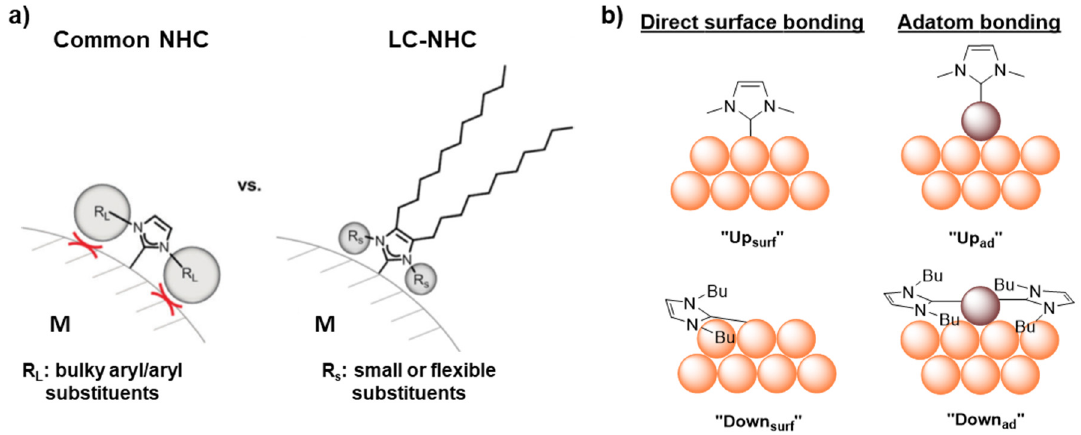
Figure 14. ( a ) Representation of NHC ligands with two different N ‐ substituents. Extracted with permission from reference 51. Copyright 2014 The Royal Society of Chemistry. ( b ) Different binding modes of NHC ligands (IBu and IMe) to the metal surfaces. Adapted from reference 87 with permission of American Chemical Society.